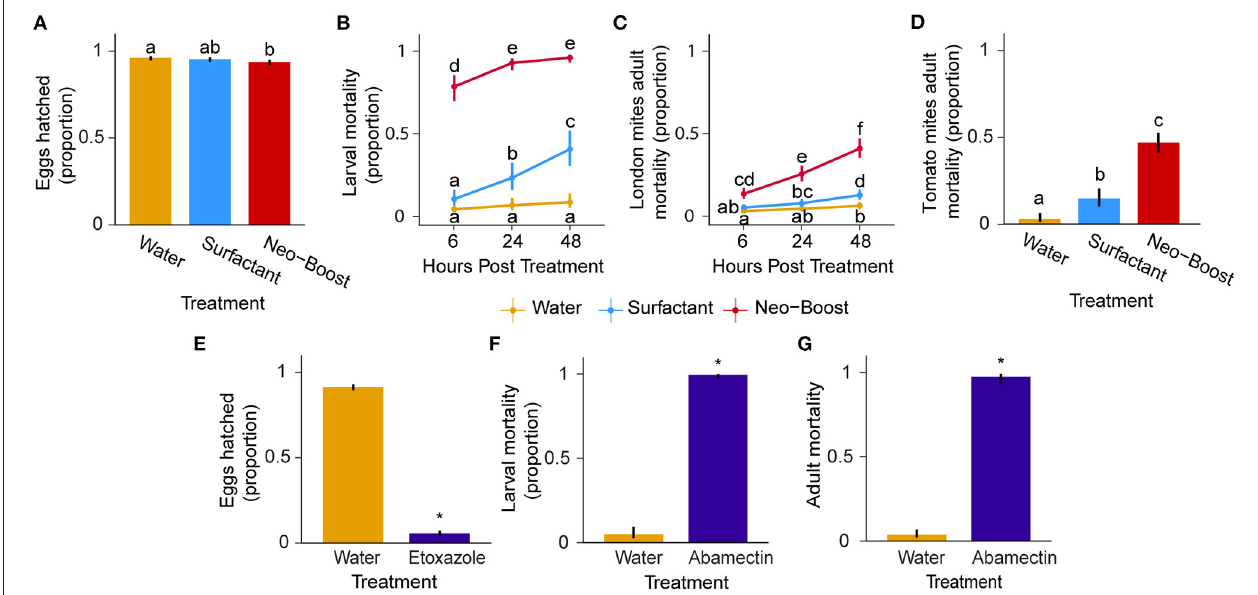
FIGURE 2 | Combined contact and residual effects of Neo-Boost, surfactant and water on age-synchronized spider mites at 6, 24, and 48 hours post-spraying (5 days for hatchability). (A, E) Hatchability of London mite eggs ( n = 30/treatment). (B, F) Mortality of larvae ( n = 60/treatment). (C, D, G) Mortality of adult mites. London strain (C, G) and “tomato mite” strain (D) , ( n = 30/treatment each). Shown are proportions of hatched eggs/dead mites ± 95% confidence interval (CI). Means with different letters within graphs are significantly different by Tukey’s HSD ( P < 0.05). Asterisks represent differences between means (E, F, G) .